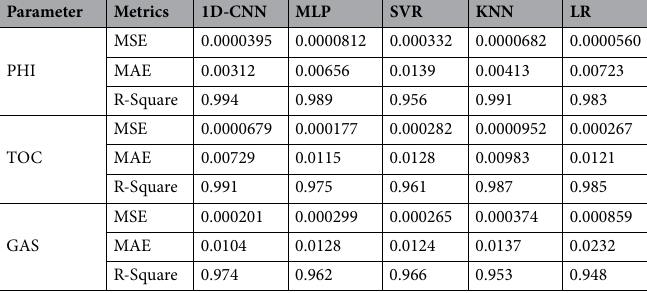
Table 1. Prediction accuracy of 1D-CNN, MLP, SVR, KNN and LR